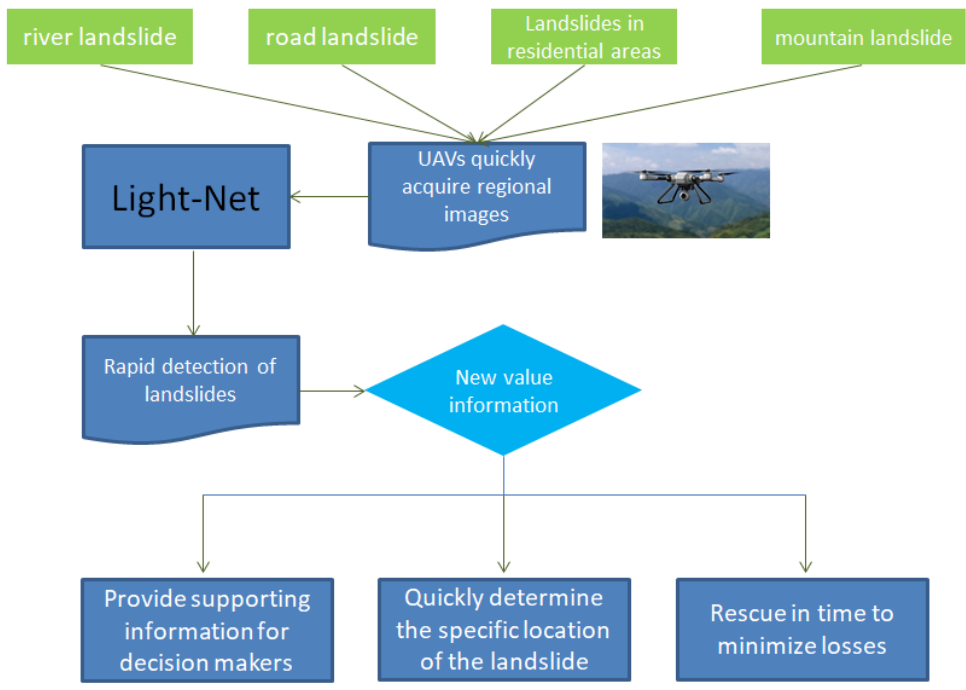
Figure 19. Landslide emergency detection flow